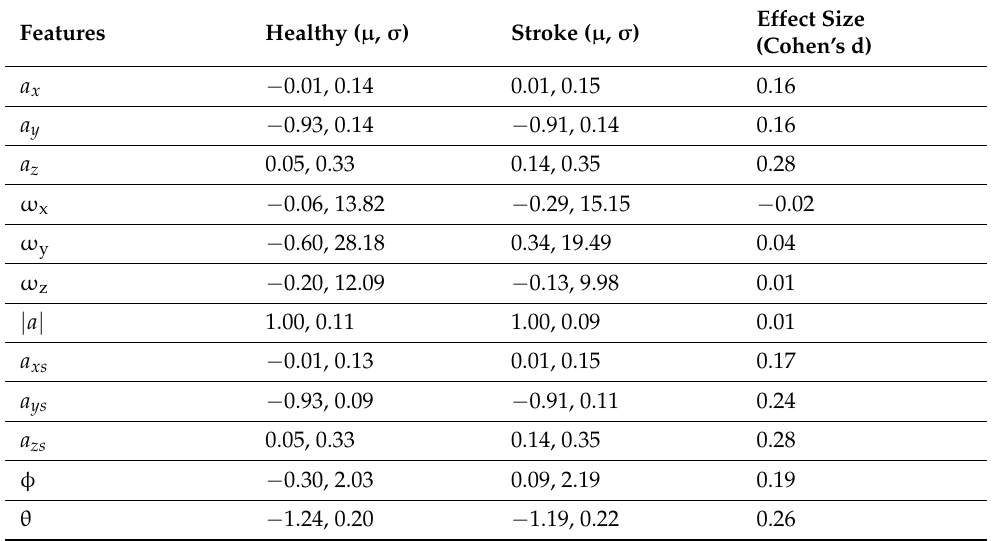
Table 1. Mean, standard deviation, and effect size of